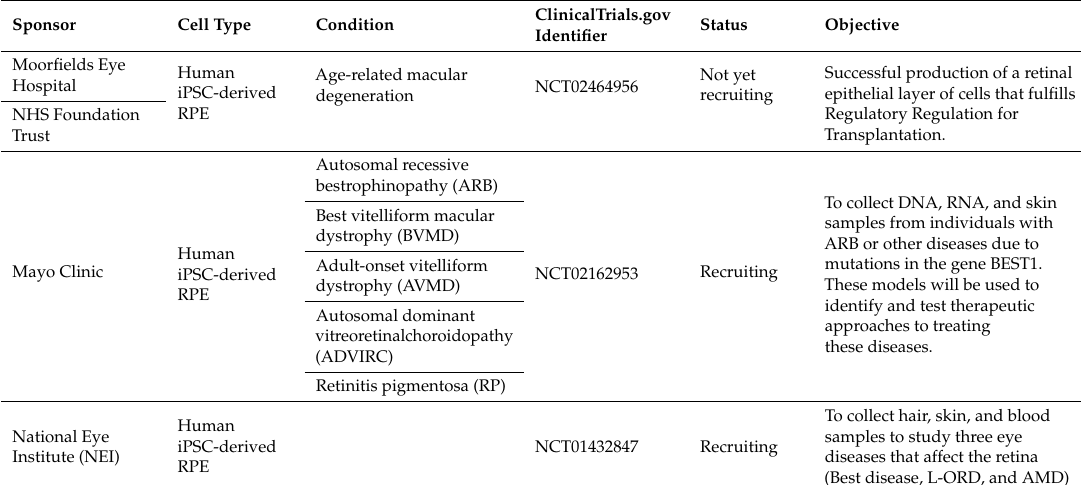
Table 3. iPSC-derived RPE-based studies for inherited and non-inherited macular degenerations. Study type: Observational. Last updated 25 October